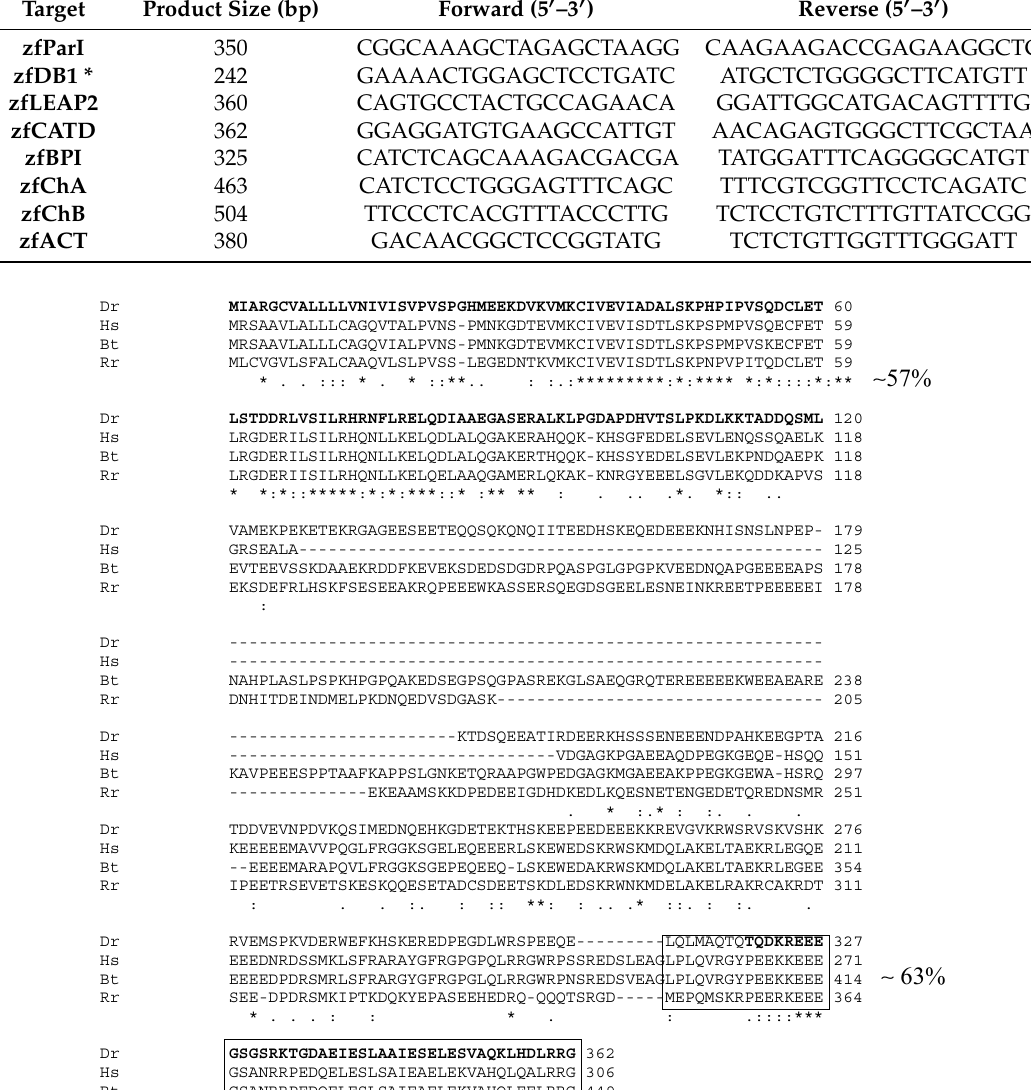
Table 1. Sequences of the pairs of primers (Forward and Reverse) employed for the reverse-transcriptase-polymerase-chain-reaction (RT-PCR) analysis in zebrafish (zf). Parasin I (ParI), β -defensin 1 (DB1), liver-expressed antimicrobial peptide 2 (LEAP2), catepsin D (CATD), bactericidal permeability-increasing protein (BPI), Chromogranins A and B (CgA, CgB), β -actin (ACT); (*) Access number: NM_001081553.